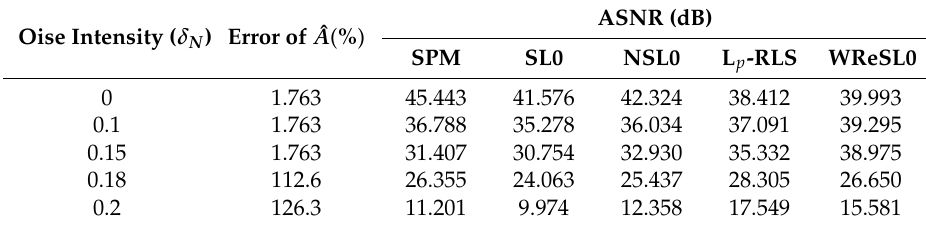
Table 5. Average SNR (ASNR) analysis for separated signals by SPM, SL0, NSL0, L p -RLS, and the proposed WReSL0 with δ N changing according to sequence [0,0.1,0.15,0.18,0.2] with 100 runs. ASNR (dB) Oise Intensity ( δ N ) Error of ˆ A ( % )